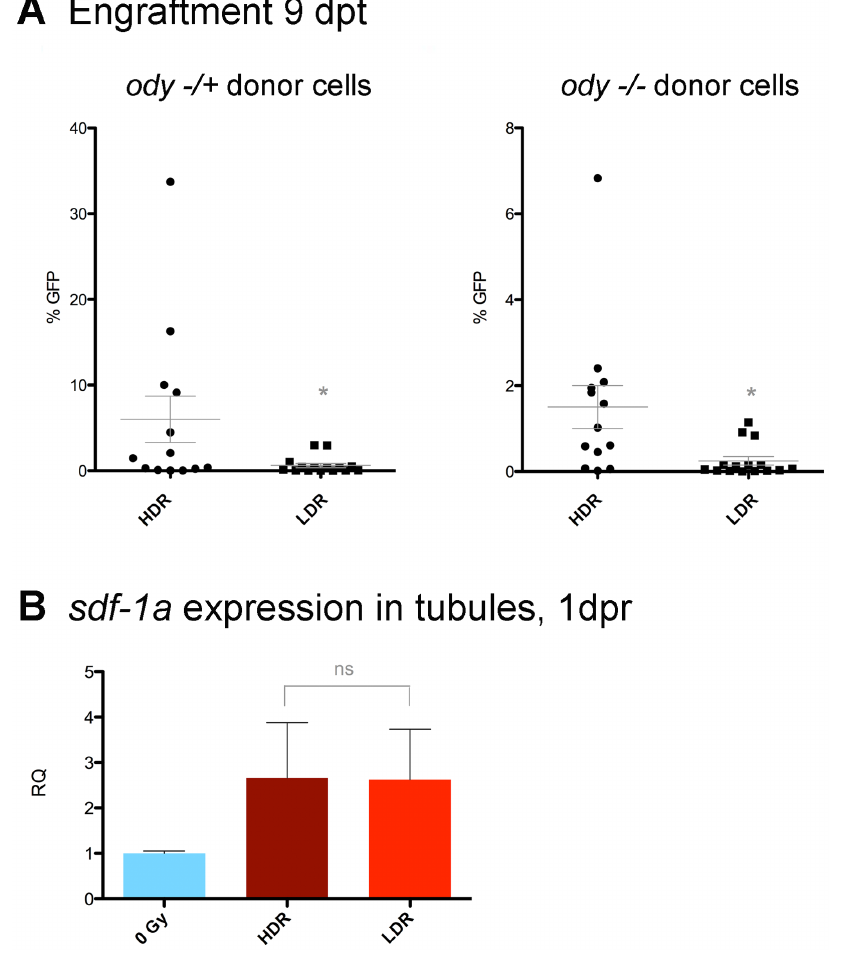
Figure 6. Dose-Rate effect does not require cxcr4b in transplanted cells. A) WT zebrafish were irradiated with 20 Gy at either dose rate and transplanted with WKM from Tg( bactin :EGFP) WKM that was either heterozygous or homozygous for the odysseus ( cxcr4b ) mutation. 9 dpt, kidneys were harvested and analyzed by flow cytometry. Data shows pooled results from two biologically independent trials, n=13–15 fish per group. Heterozygous: p=0.0420, Homozygous mutant: p=0.0141, (unpaired t-test). B) 1 day after radiation, samples enriched for renal tubules were collected from WT zebrafish and analyzed by qRT-PCR for sdf-1a expression. No significant differences were seen between dose-rate groups. Pooled results from two biological experiments, each with four fish per group, are shown. RQ: Relative